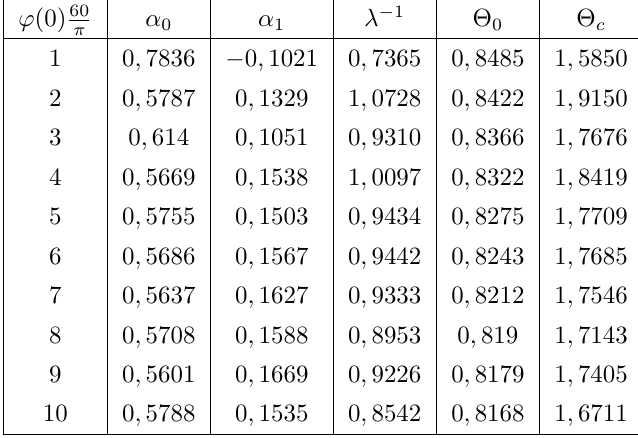
Table 7 . Length parameters for